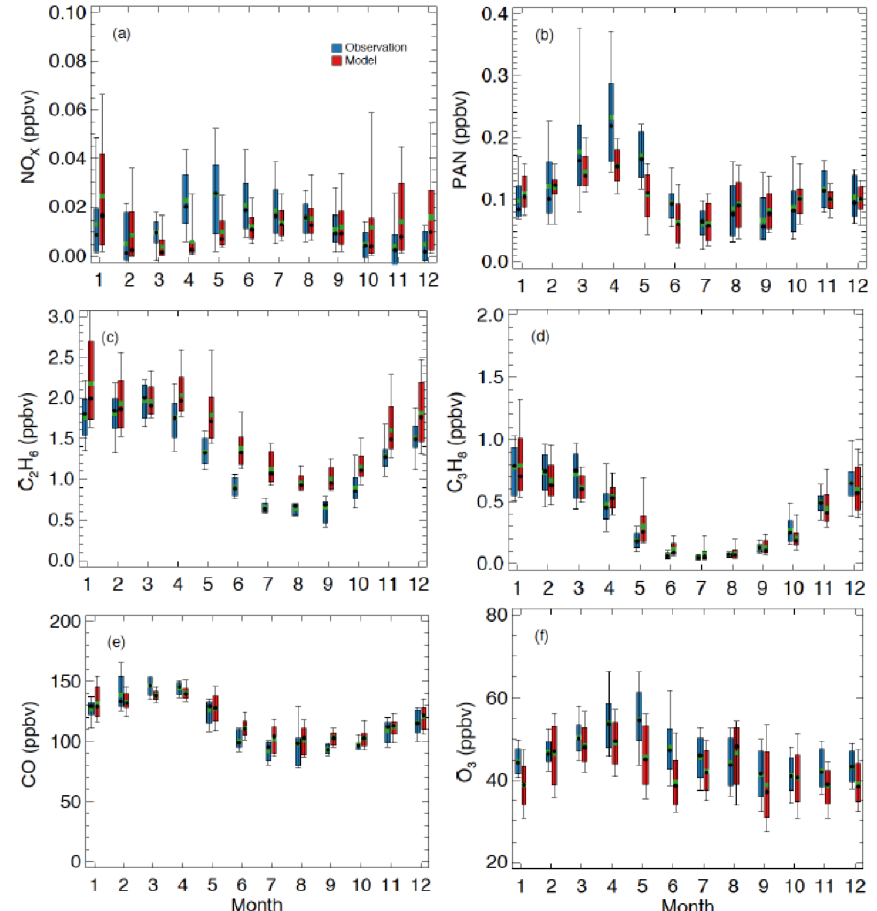
Figure 1. Box plot comparison for seasonal variations in (a) NO x , (b) PAN, (c) C 2 H 6 , (d) C 3 H 8 , (e) CO, and (f) O 3 between GEOS-Chem model simulations (red) and measurements (blue) at Summit for the period July 2008–June 2010. Data shown are monthly averages during this period. The thick (thin) bars represent the 67% (95%) confidence intervals. Black and green dots represent median and mean values, respectively. The statistics are based on daily averages.